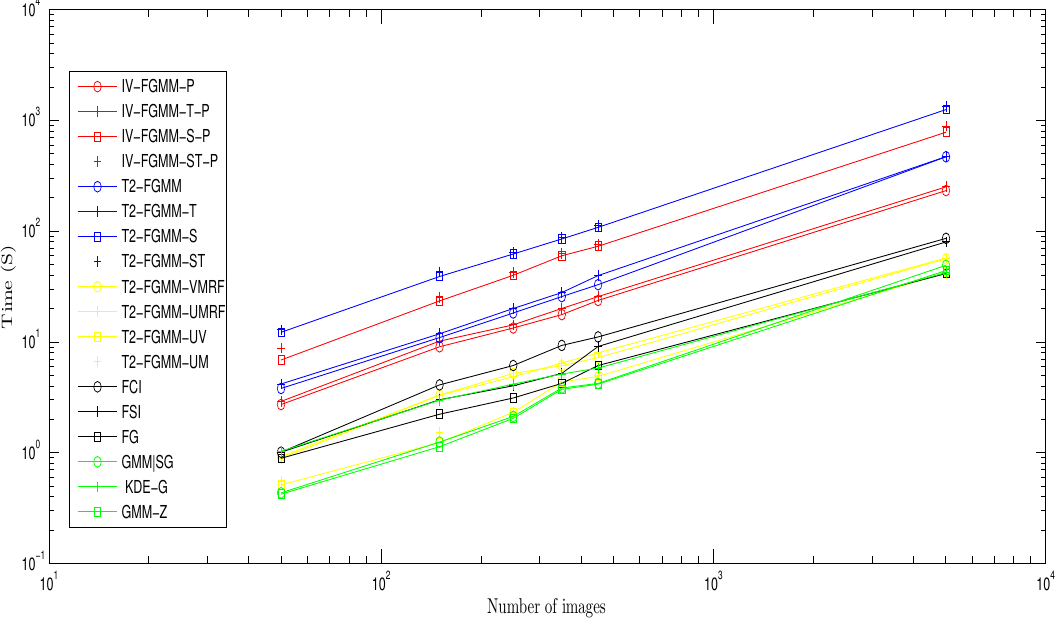
Figure 11. Calculation time according to the number of images in the video